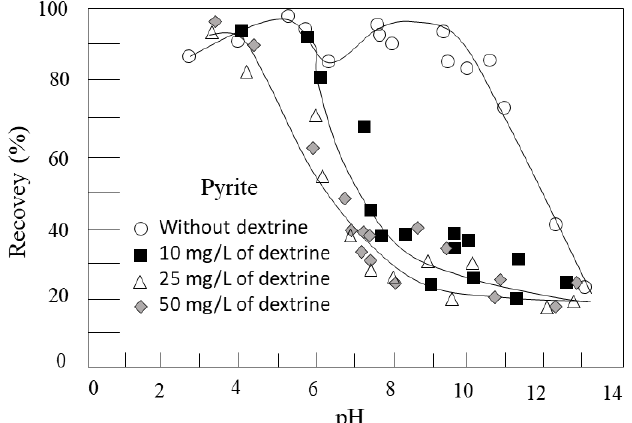
Figure 38. Pyrite floatability with 1 × 10 − 4 mol/L sodium isopropyl xanthate as a function of pH in the absence and presence of various initial concentrations of dextrin [1 g of pure pyrite ore with a nitrogen flow rate of 30 mL/min. Deionized water was used, adjusting the pH with dilute solutions of NaOH and HNO 3 ] (adapted from Valdivieso et al. [135]).